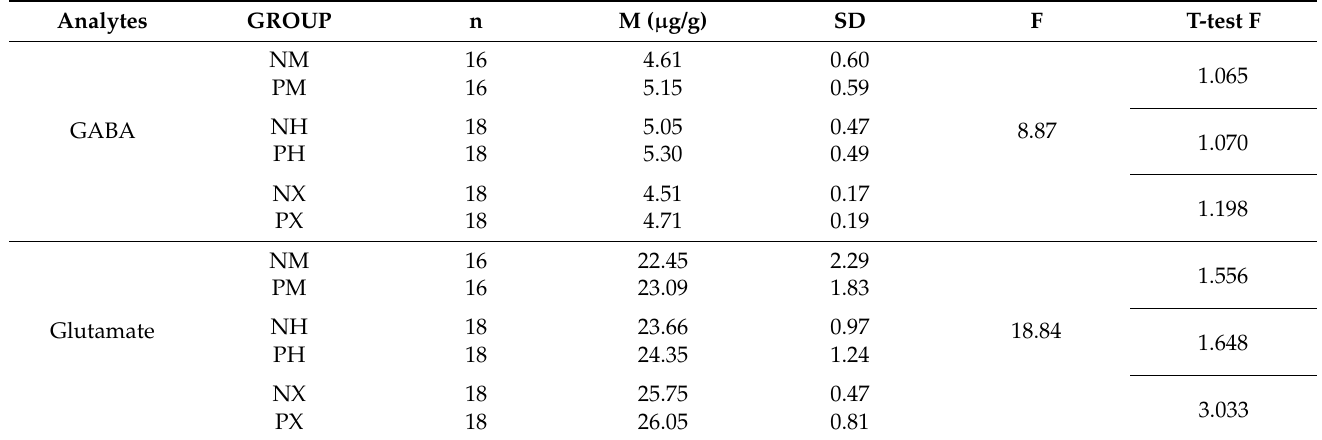
Figure 3. Effect of exercise and probiotics ingestion on major neurotransmitters of the brain. Summary bar graphs showing the concentrations of GABA (left panel) and glutamate (right panel) in cerebellar lysate from mice brains. GABA and glutamate were detected by LC-MS/MS. GABA concentrations are increased by ingestion of probiotics. GABA and glutamate concentrations are also affected slightly by exercise intensity. Values are presented as mean ± SD; ##; p < 0.01, ###; p < 0.001. The significant difference was indicated by One-way ANOVA. *; p < 0.05. Significant difference was indicated by independent t -test. N, no probiotics; P, probiotics; M, moderate-intensity exercise; H, high-intensity exercise; X, no exercise. Table 4. Statistical values of major neurotransmitters in brain. GABA and glutamate were detected by LC-MS/MS. Values are presented as M (mean, µ g/g) and SD (Standard Deviation). One-way ANOVA evaluated the significant difference. N, no probiotics; P, probiotics; M, moderate-intensity exercise; H, high-intensity exercise; X, no